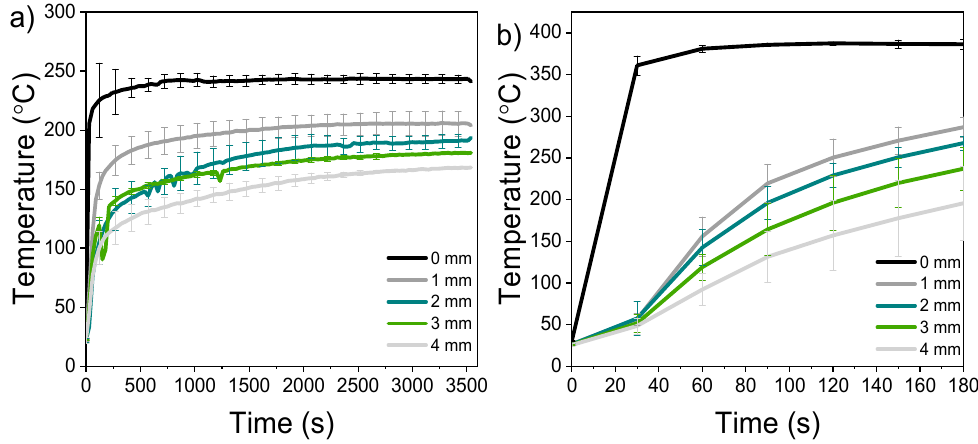
Figure 1. Temperature profiles measured from ( a ) samples modified at 250 °C, 60 min and ( b ) 400 °C, 3 min, average of three. See Table 1 for sample codes.